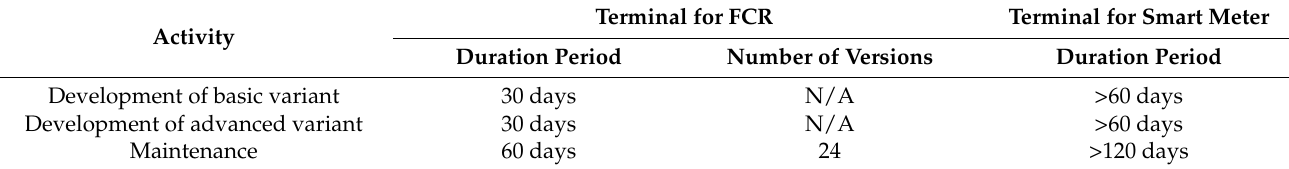
Table 1. The results of applying model-driven development method to the terminal for remote control of fiscal cash registers and a comparison with the results of the development of a terminal for remote control of smart meters without applying this